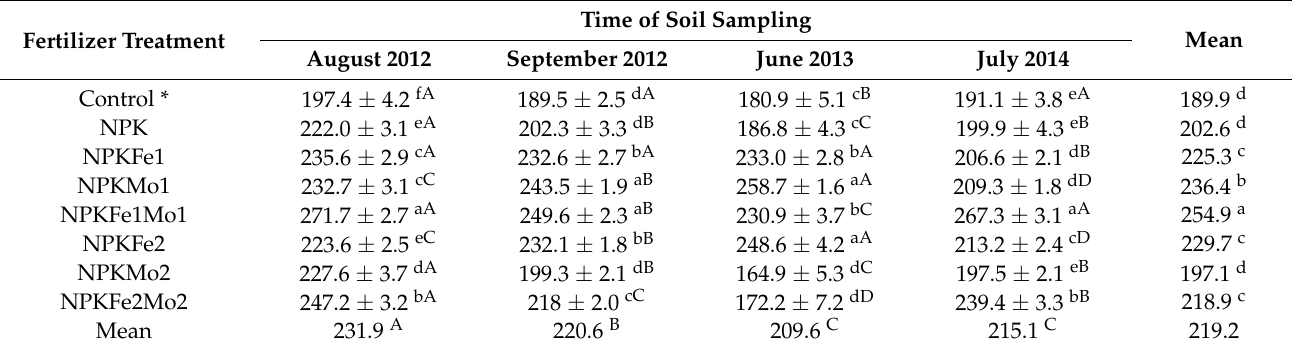
Table 9. Biochemical index (BCHI) of soil